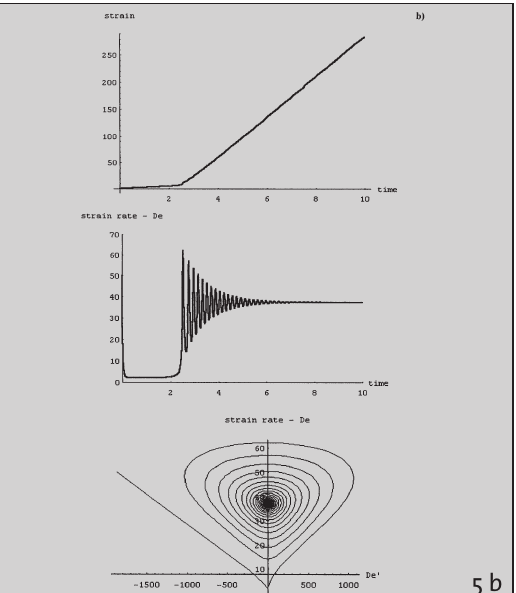
Figure 5 (left): Time dependent numerical solutions: γ (t), De(t) and De(De· ) of Eq. 5 at τ – (0) = 0.4, κ = 0.01, De(0) = 50 and three different values of De·